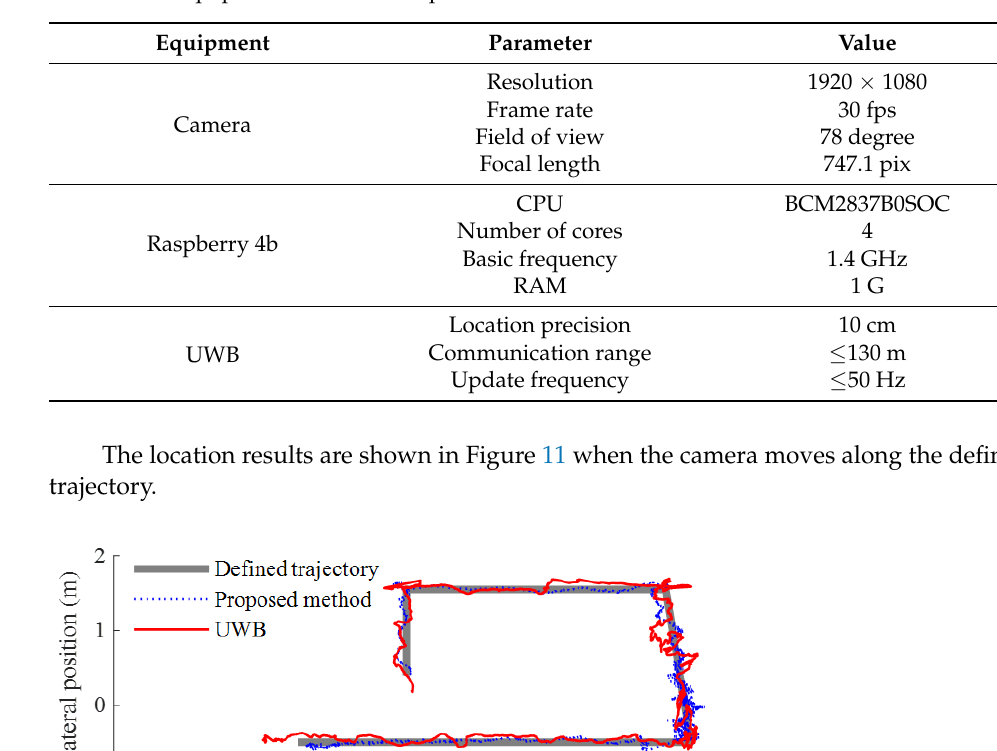
Table 1. Test equipment and technical parameters.